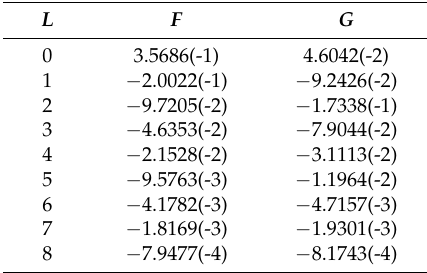
Table 3. Matrix element for k = 1.0.